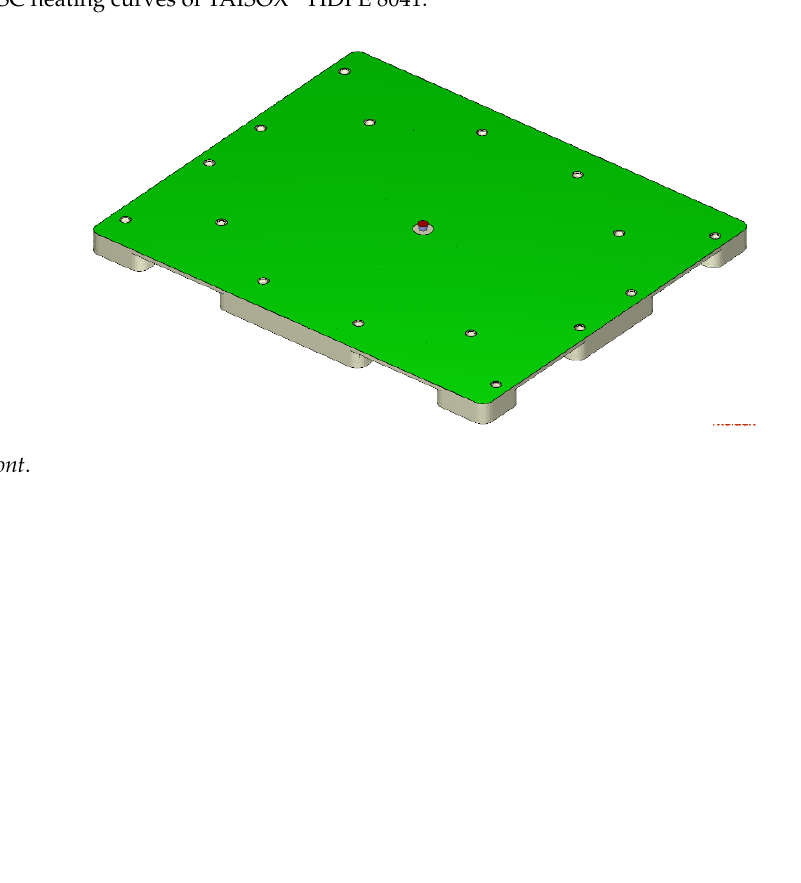
Figure 1. DSC heating curves of TAISOX ® HDPE 8041.